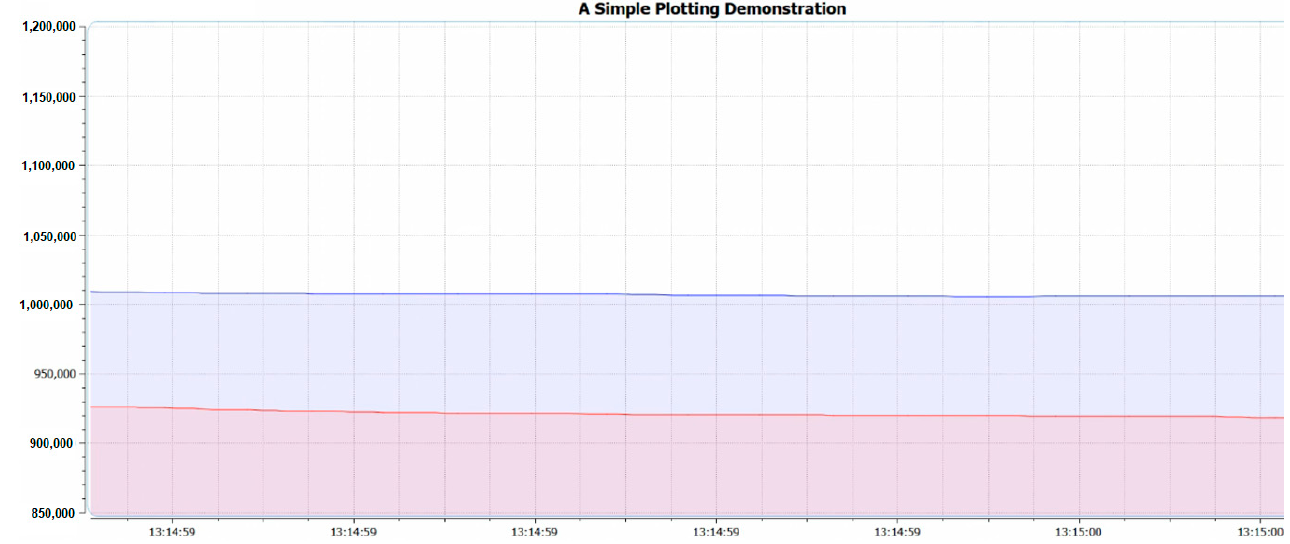
Figure 3. MAGIC_ACCEPTABLE_INTENSITY_DIFF (MAID) is too large.